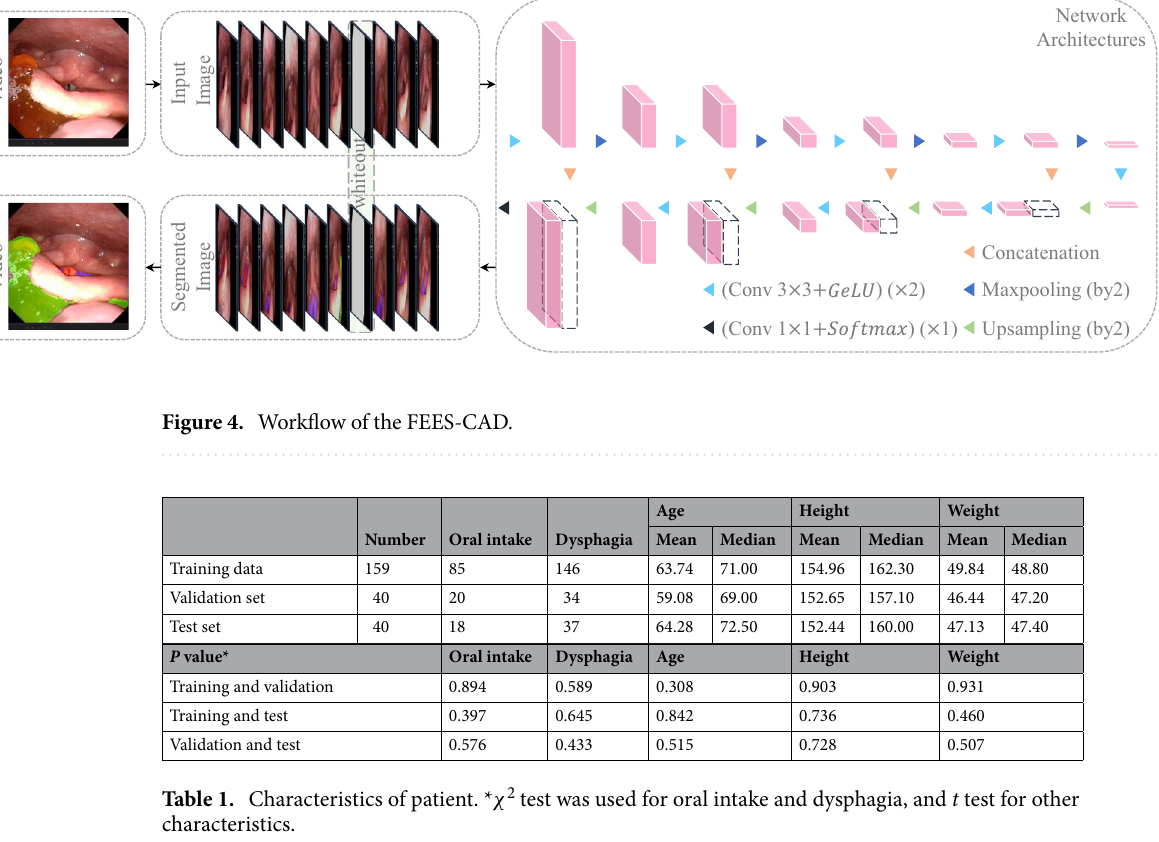
Table 1. Characteristics of patient. * χ